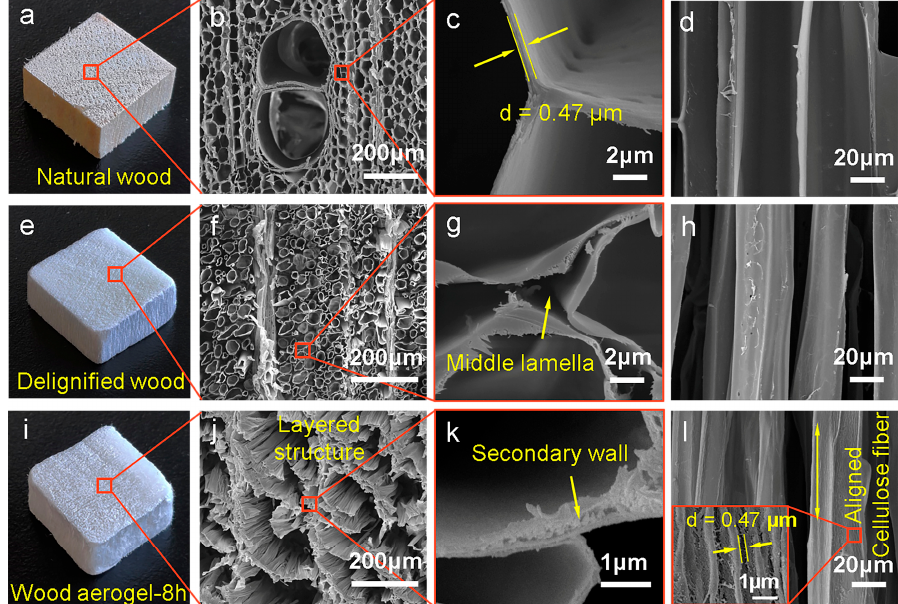
Figure 2. Morphology of different wood specimens. ( a ) Photograph of the natural wood. ( b – d )